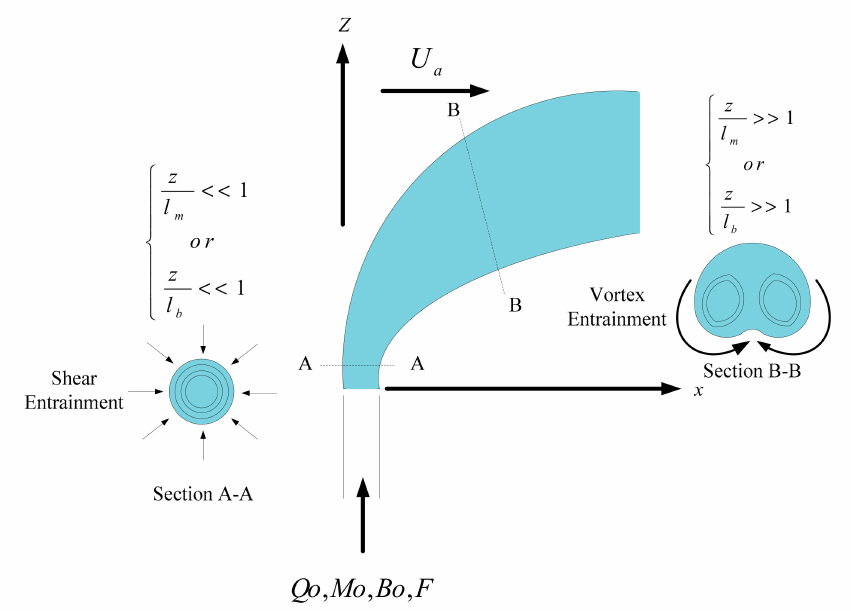
Figure 3. Flow regimes of a cross-flow buoyant